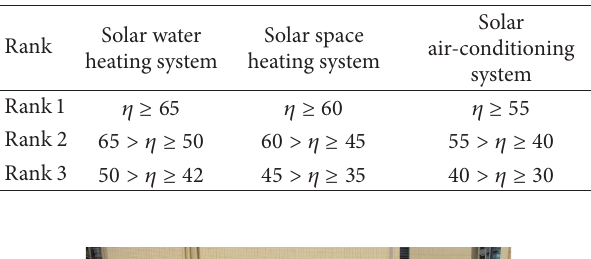
Table 8: Rank of the efficiency for a solar collecting system.